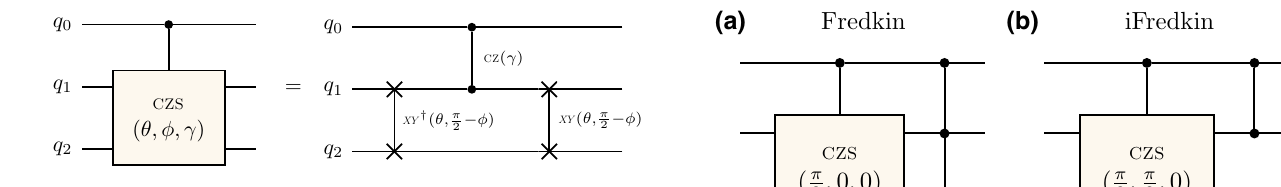
FIG. 2. Decomposition of the three-qubit CCZS gate into two- qubit gates. Note that, for the case of a linear chain [see Fig. 1(a)], the control qubit q 0 in the CCZS gate is the middle qubit, but the decomposition into two-qubit gates requires q 1 to be the middle qubit, since it has to interact with both q 0 and q 2 .